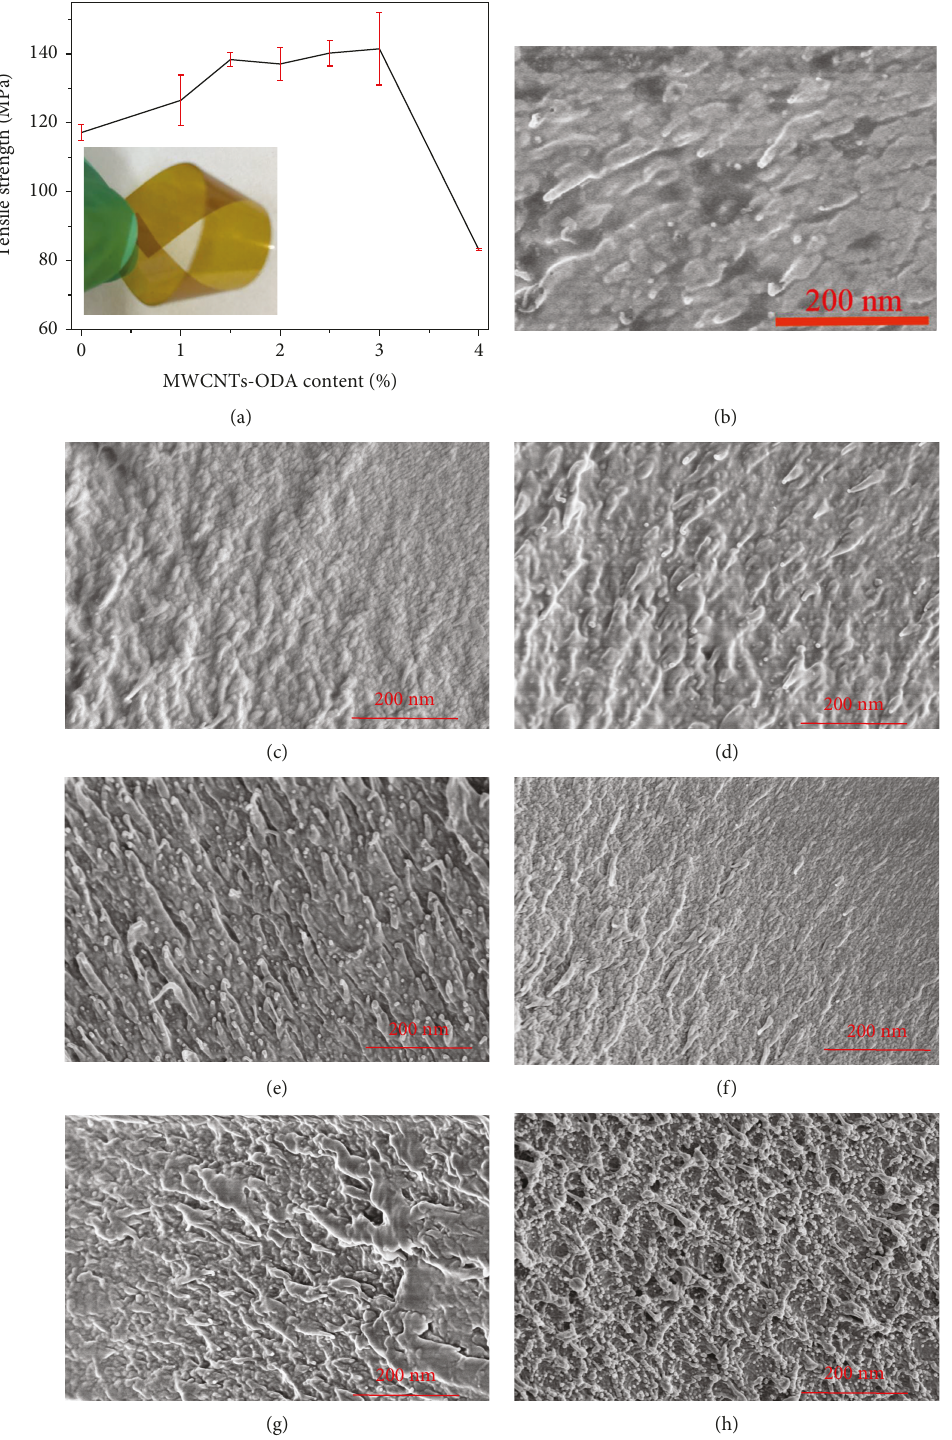
Figure 6: (a) Tensile strength curves of PI composite fi lms and (b – h) SEM images of pure PI and MWCNTs-ODA/PI composite fi lms with the MWCNTs-ODA content of 0 wt.%, 1 wt.%, 1.5wt.%, 2wt.%, 2.5wt.%, 3wt.%, and 4 wt.%,